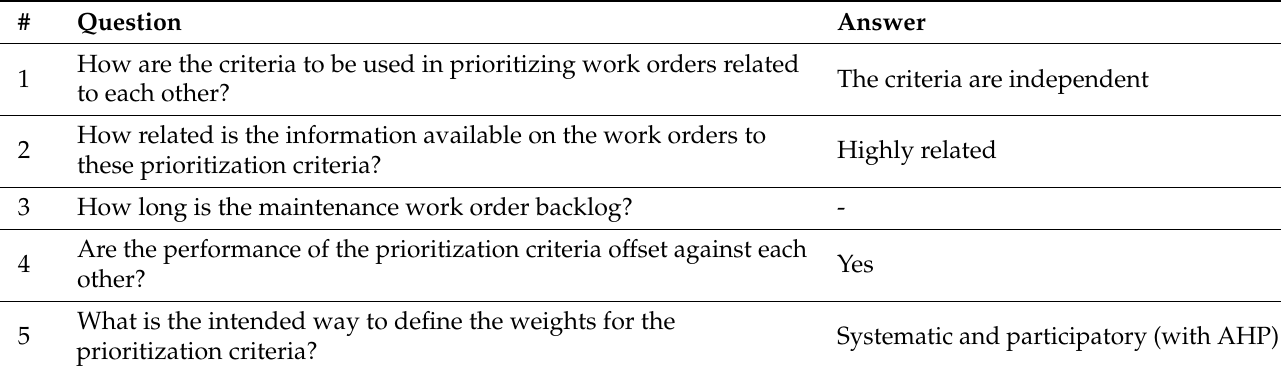
Table 4. Answers to the diagram considering the context of the case study hydroelectric plant.